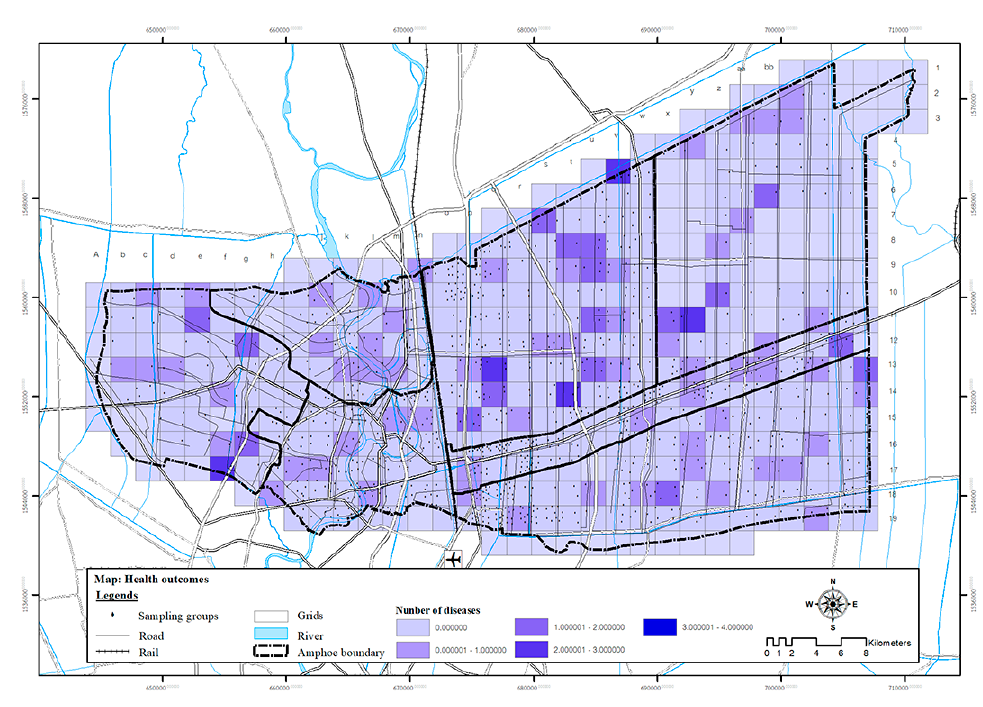
Figure 5. Clustering of Health outcomes